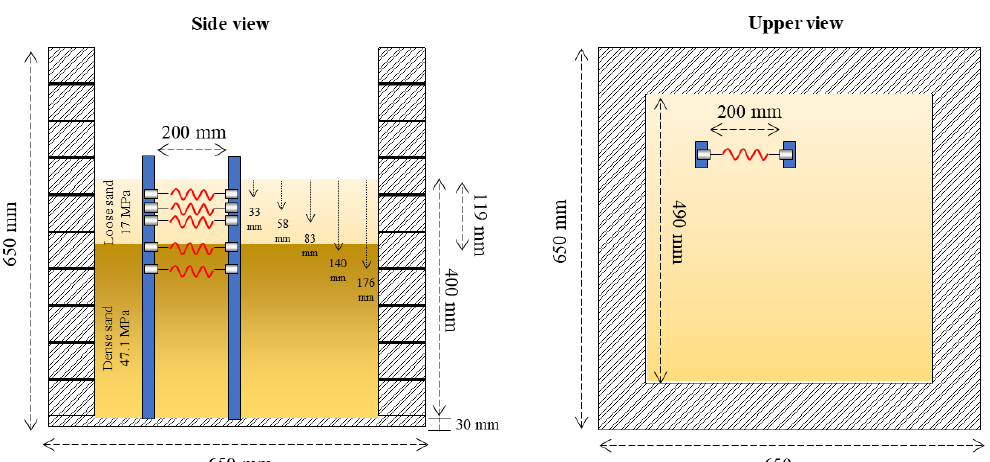
Figure 3. Schematic of (left) side view and (right) upper view of bender element arrays.